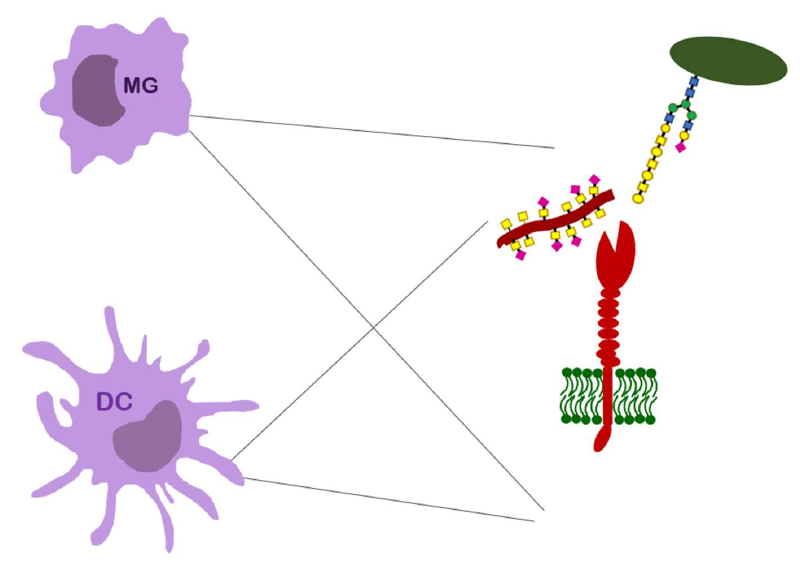
Figure 4. CLEC10a (MGL) presented on immune cells and its ligand binding.